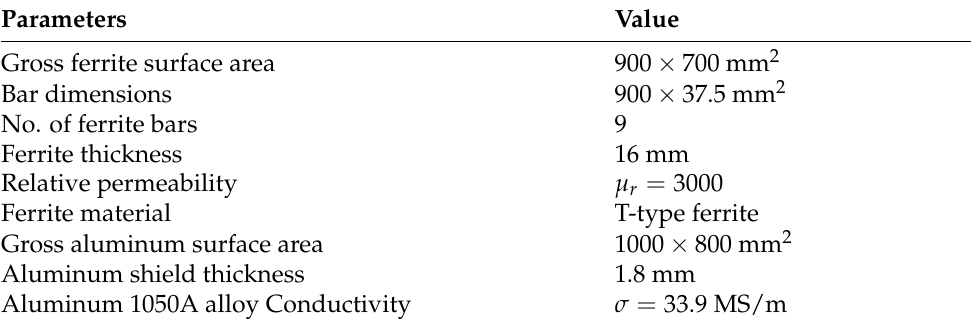
Table 1. Ferrite and shielding layer specifications.